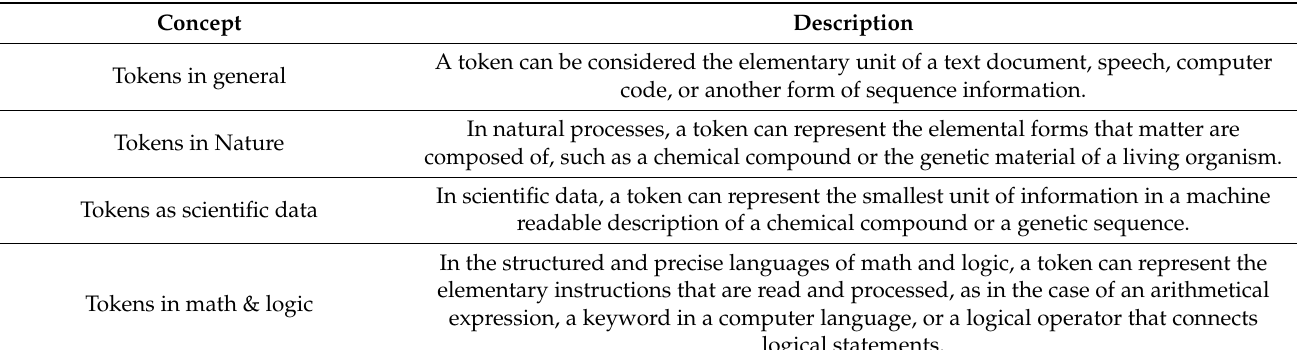
Table 1. Summary of concepts in this